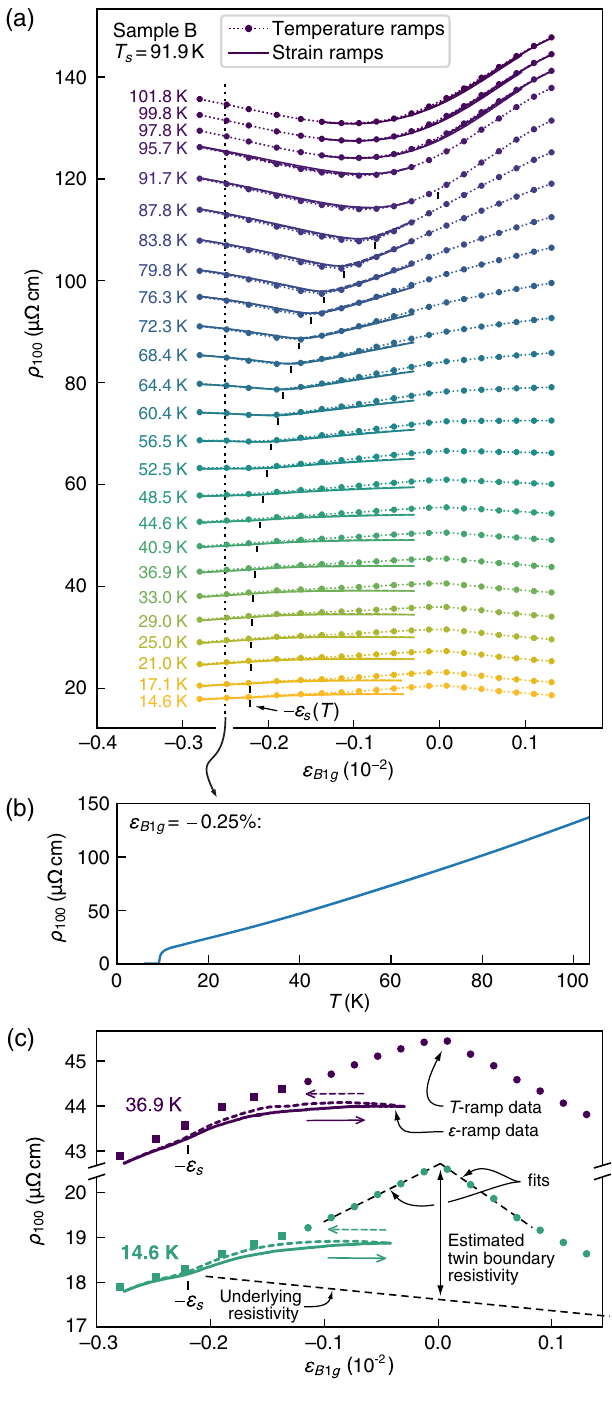
FIG. 5. (a) ρ 100 of sample B over a wide temperature and strain range. Points are data from temperature ramps at constant ε . The B 1 g < − 0 . 11 · 10 − 2 havebeenadjustedalong positionsofpointsat ϵ B 1 g the ϵ axis to correct for plastic deformation of the platform; see B 1 g Appendix A 4 for details. The lines are strain ramps at constant ð T Þ , taken as the data of Ref. [40] scaled in T and ε temperature. ε s to match the data here, is indicated at each temperature. (b) ρ 100 ð T Þ ¼ − 0 . 25 × 10 − 2 , where the sample is fully detwinned at all for ε B 1 g T . (c) Close-up of the data in (a) at 14.6 and 36.9 K. The squares mark points whose position along the ε axis was B 1 g